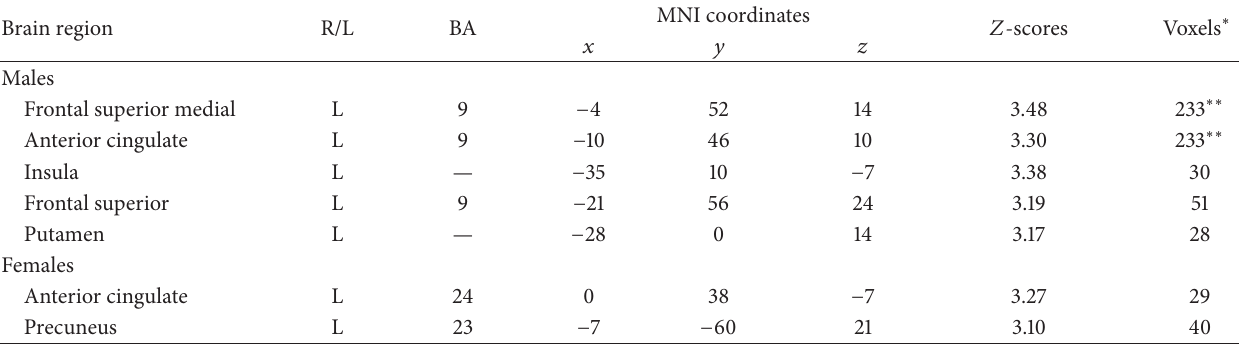
Table 1: Cerebral activations of male and female participants during viewing of craving images (relative to neutral images). R = right; L = left; BA = Brodmann area; 𝑃 is uncorrected at 0.001.